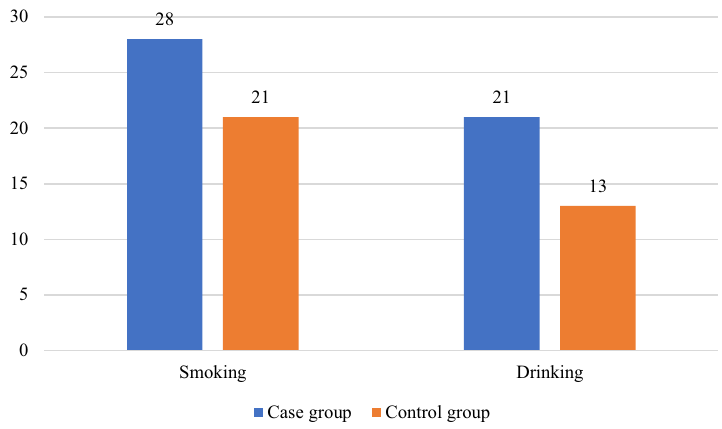
Figure 5. The numbers of subjects with smoking and drinking habits in the case and control groups.